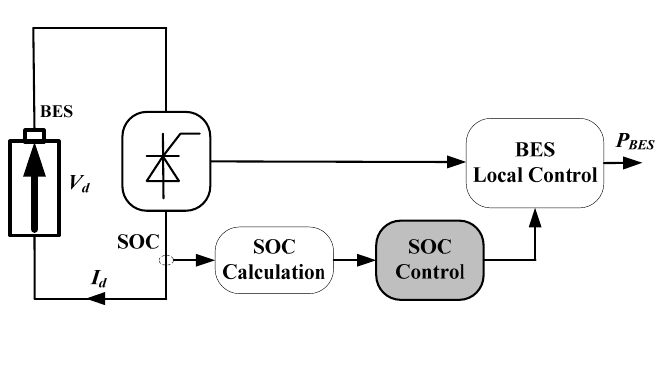
Figure 6. SOC local control structure.